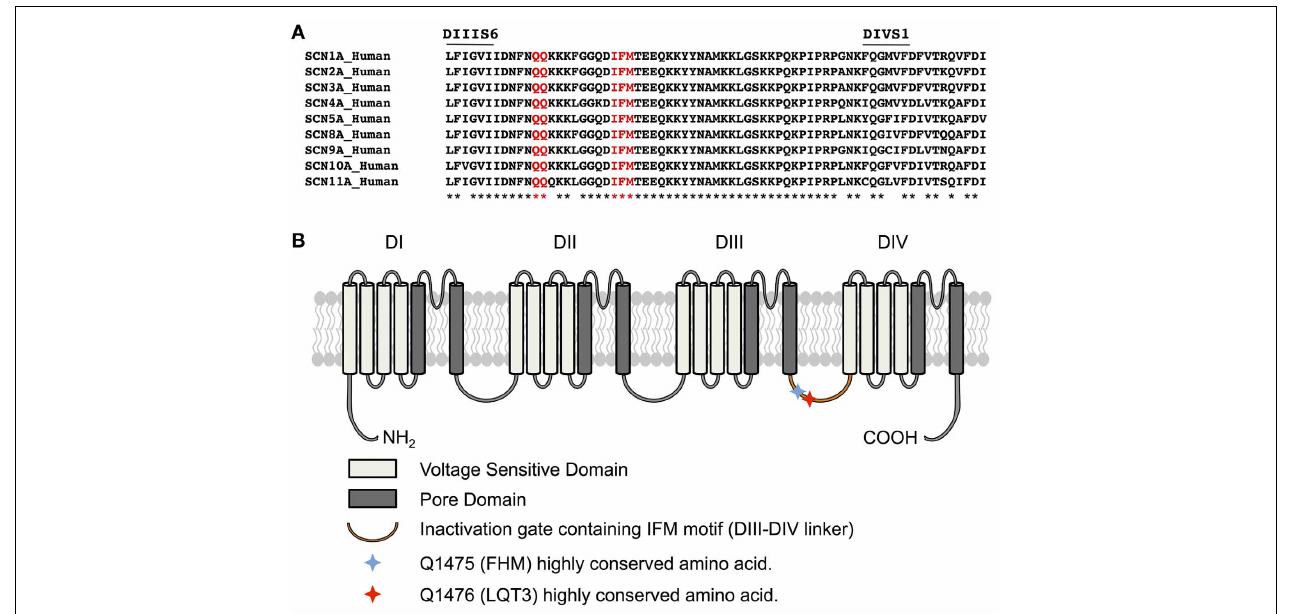
sensitive domains, the segments forming the pore domain, and the inactivation gate. Q1475 and Q1476 are also indicated. The missense mutation of one these two amino acids leads to several pathologies, depending on the channel impacted. The mutation of Q1475 in Na v 1.1 causes familial hemiplegic migraine (FHM), whereas the mutation of Q1476 in Na v 1.5 causes LQT3